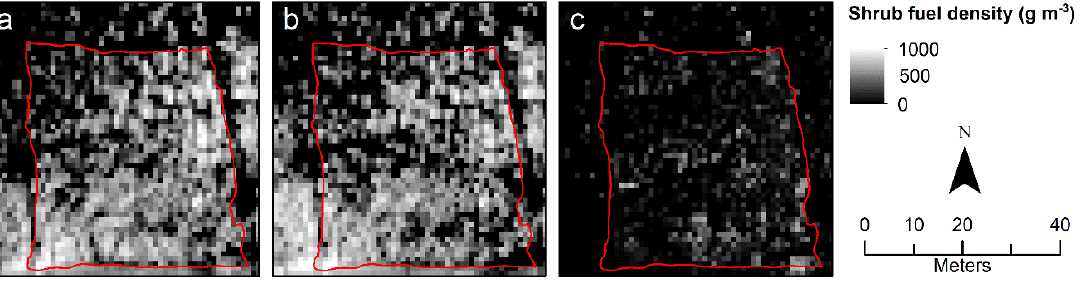
Figure 4. Fuel density rasters for unit 16D1 derived from TLS point cloud data at 1 m resolution and depicting ( a ) prefire fuel density, ( b ) postfire fuel density, and, by difference, ( c ) consumed fuel density. If estimated consumption was less than 0, it was assigned a value of